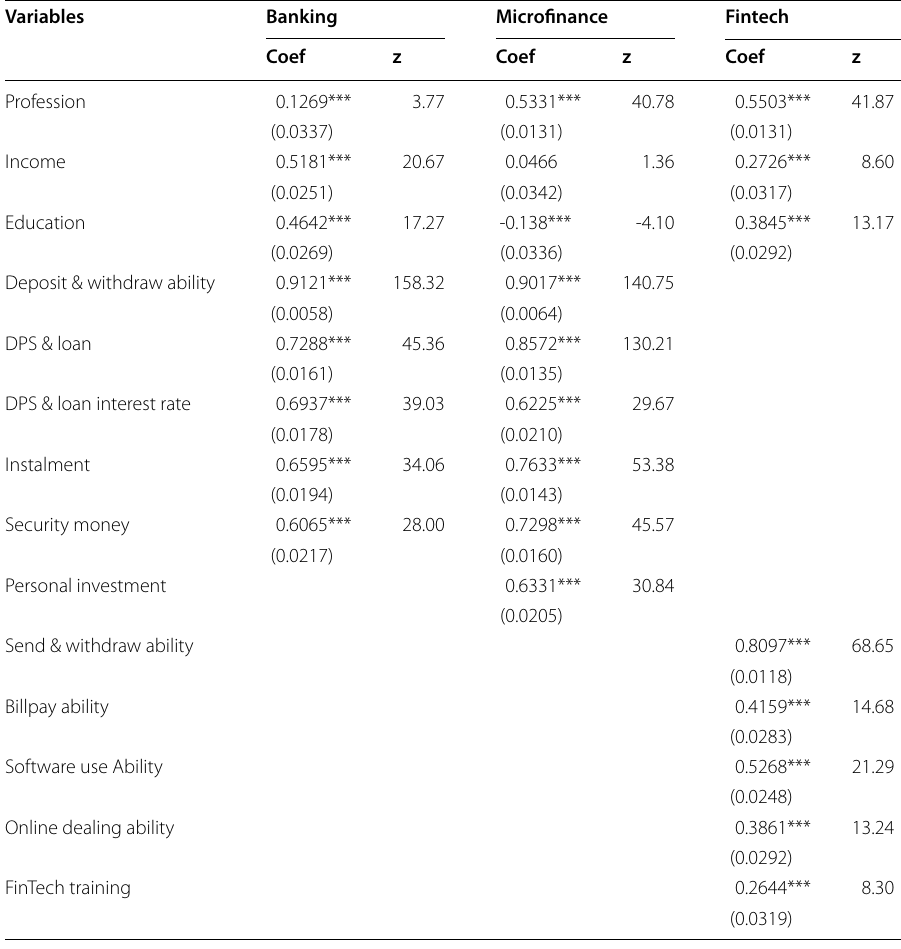
The Comparative fit index (CFI) value for each single model is 1.0, the value of Prob > chi2 is 0.000. *** refers the p -value is more than 0.001, the value within the first bracket is the OIM standard error